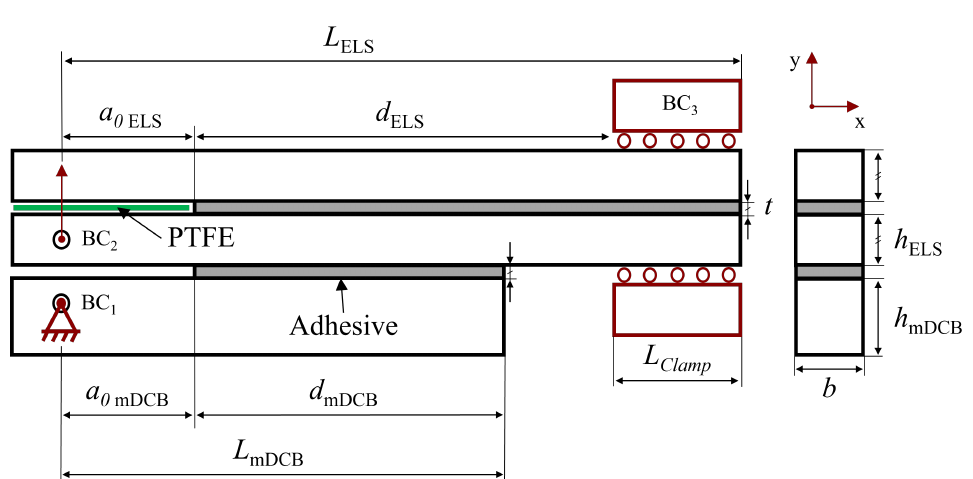
Figure 4. Schematic representation of the mDCB and ELS fracture specimen, with its associated dimensions, testing procedure and respective boundary conditions.